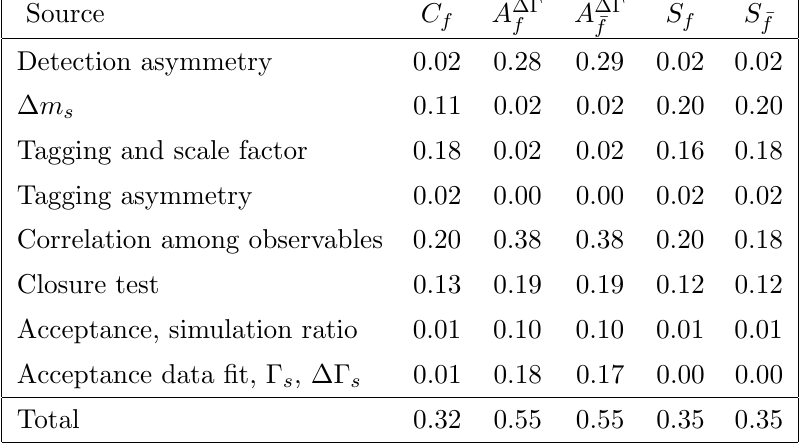
Table 5 . Systematic uncertainties on the CP parameters, relative to the statistical uncertainties.